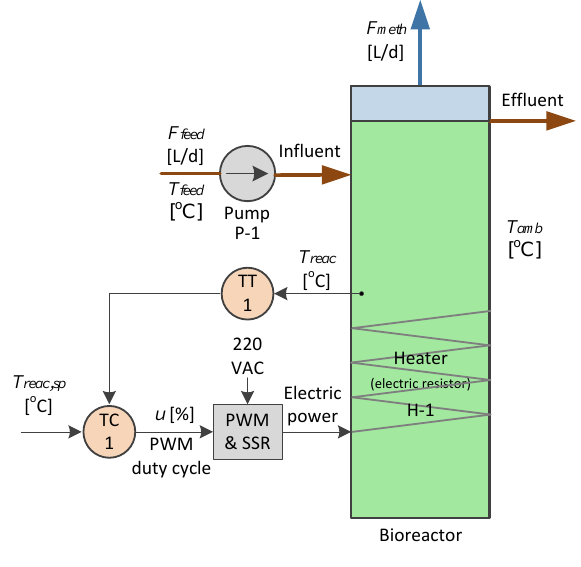
Figure 1: Temperature control system for AD reactor. The feed temperature, T feed , is assumed to be the same as the ambient – here: room – temperature, T amb , since the feed resides for several days in an intermediate storage in the room where the reactor is placed. Detailed information about the system components are given in the